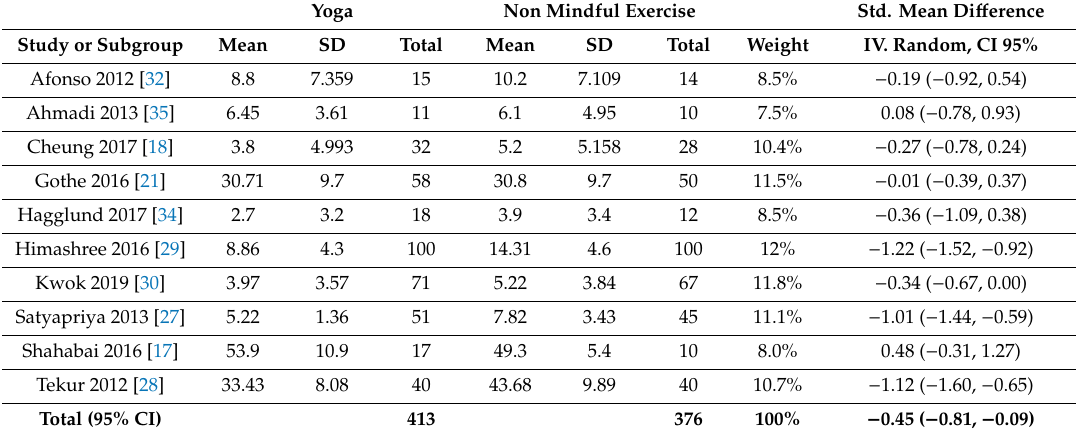
Figure 4. Effect of yoga on anxiety symptoms in comparison to non-mindful exercise.